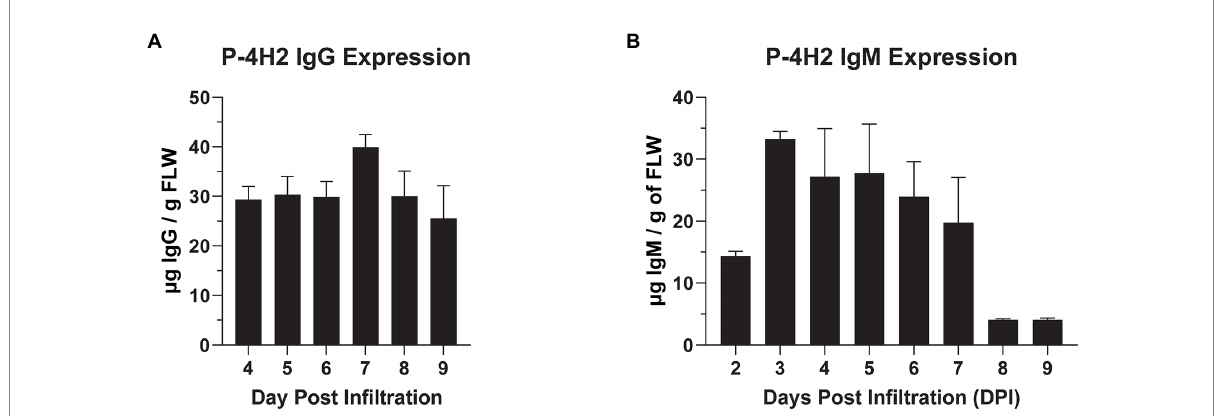
FIGURE 1 Temporal expression of 4H2 Isotypes in Nicotiana benthamiana leaves. Δ XTFT N. benthamiana leaves were infiltrated with P-4H2 IgG or P-4H2 IgM gene constructs and leaf proteins were extracted 2–9 days post infiltration (PDI). The expression of P-4H2 IgG (A) and P-4H2 IgM (B) human chimeras was analyzed by a sandwich ELISA that detects only fully assembled IgG or IgM (containing both human kappa light chain and either human gamma or human mu heavy chain) from total soluble plant protein extracts. Mean ± SEM from at least two independent experiments is plotted.